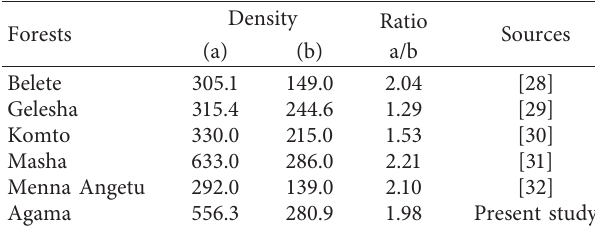
Table 2: Comparisons of tree and shrub densities with DBH 10–20 cm (a) and tree density with DBH > 20cm (b) from Agama Forest with 5 other moist Afromontane forests in